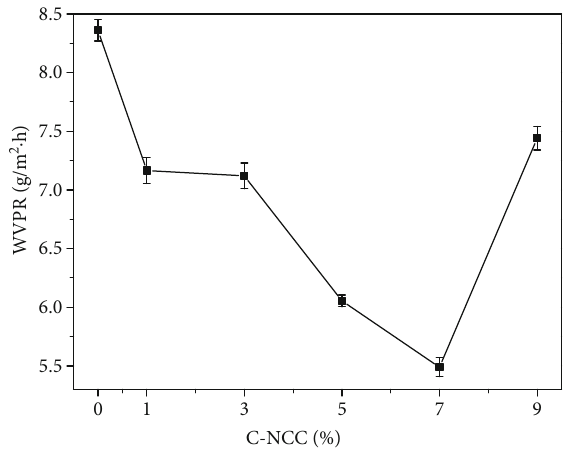
Figure 2: E ff ect of the C-NCC content on the WVPR of composite fi lms.